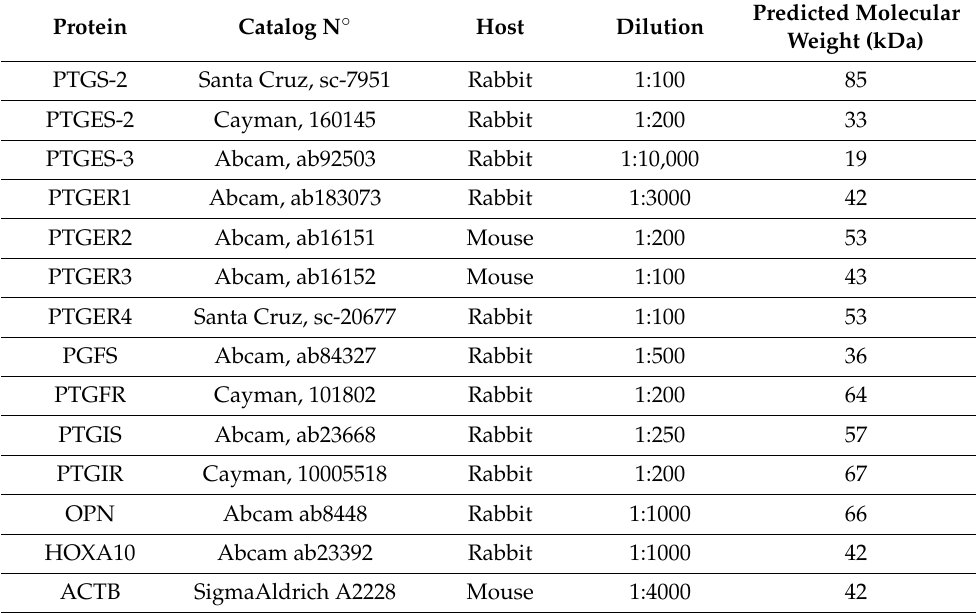
Table 2. Antibodies used for Western